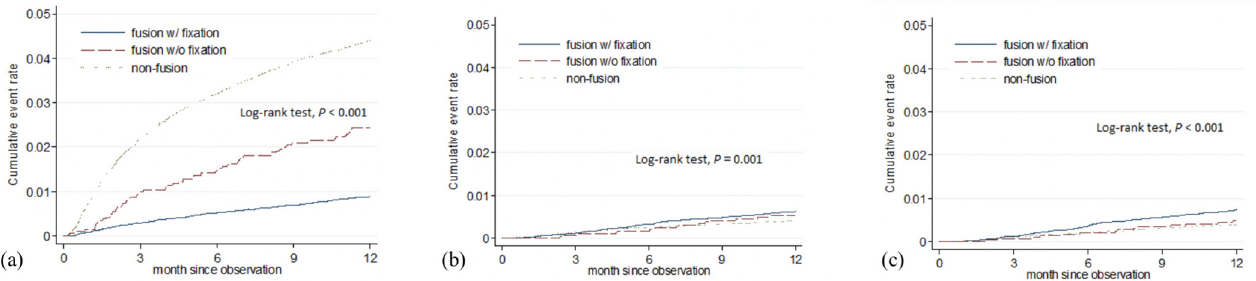
Figure 2. The cumulative event rate of spine reoperation ( a ), total hip replacement ( b ), and total knee replacement ( c ) after short-segment spinal surgery for degenerative disc disease.